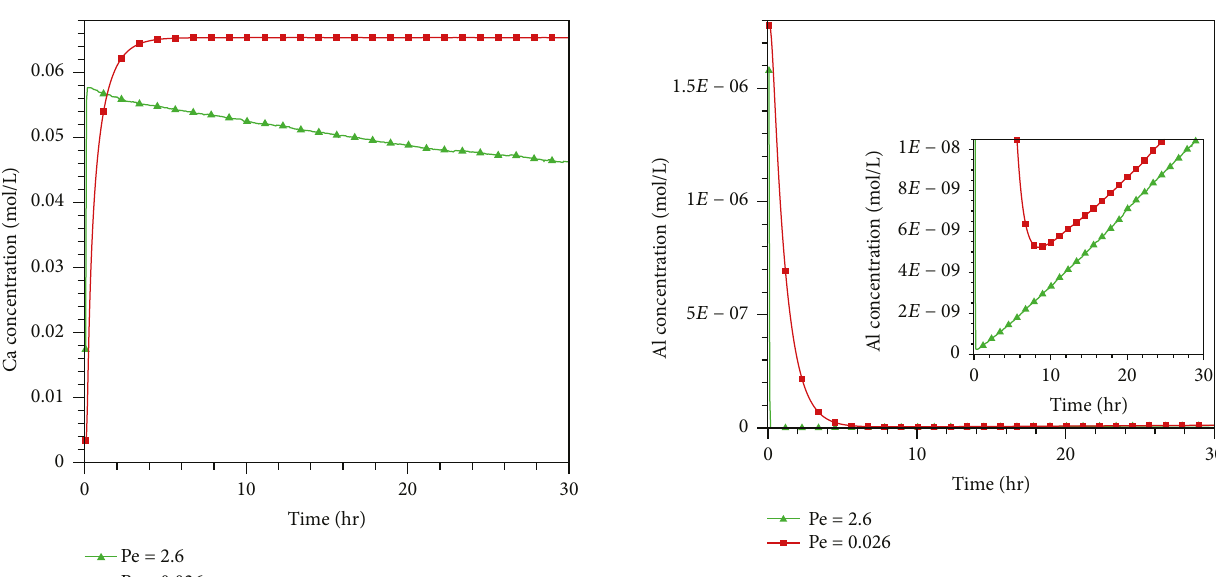
Figure 29: E ffl uent Al concentrations versus time at two di ff erent Pe numbers.